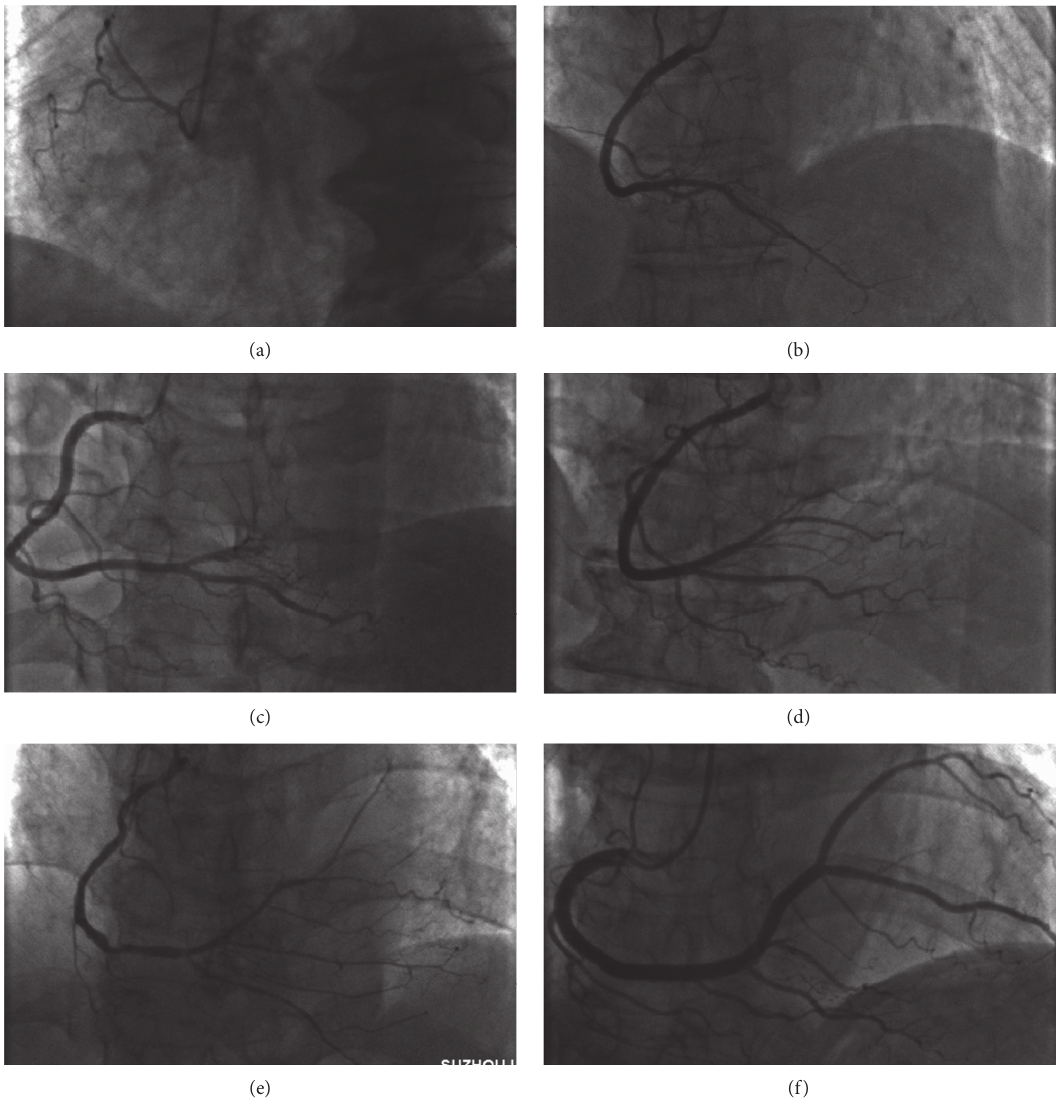
Figure 1: Failures in reflection of the variability in RCA blood supply to the LV in the SYNTAX score. (a) The RCA did not supply blood to the LV, which was defined as left dominant in the SYNTAX score. (b)–(f) The RCA, varying greatly in size, supplied blood to the LV, which was defined as right dominant and was assigned the same weighting in the SYNTAX score. LV � left ventricle; RCA � right coronary artery.